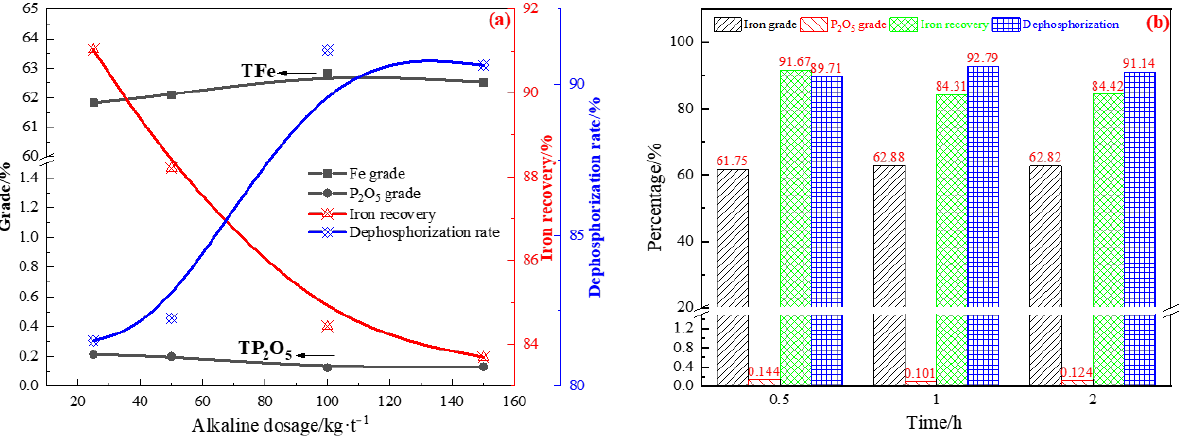
Figure 7. Effect of alkaline leaching parameters on the upgrade of iron and removal of phosphorus ( a ) alkaline dosage; ( b ) alkaline leaching time.